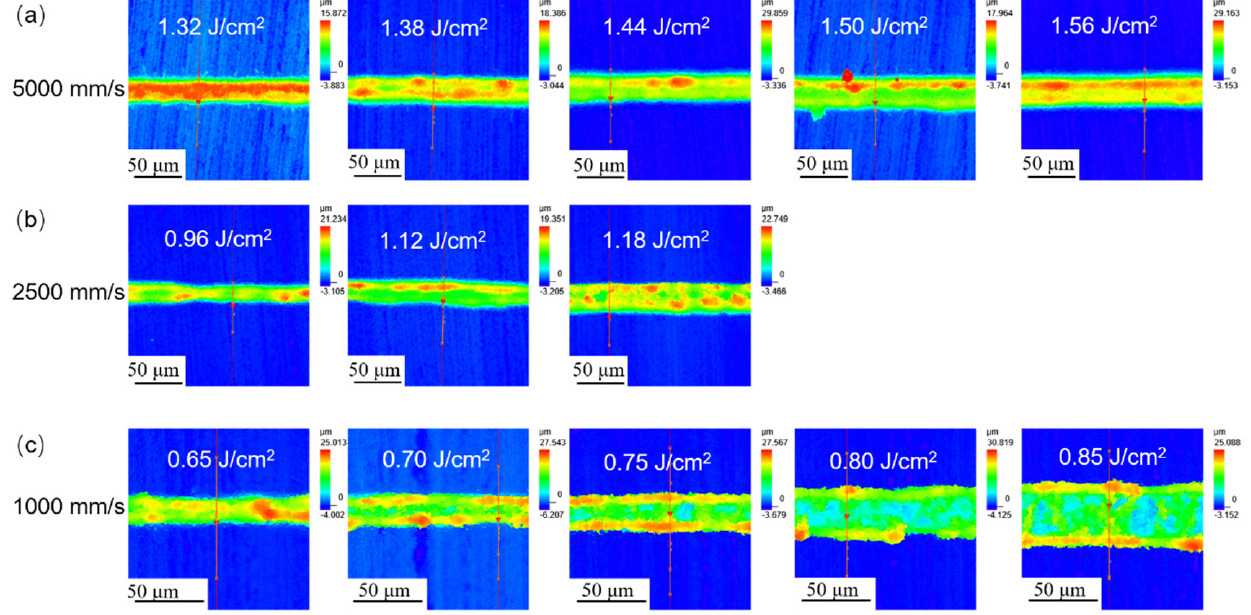
Figure 2. Two-dimensional morphology of the formed lines under different laser fluences and pro- cessing speeds obtained by LSCM. ( a ) 1.32–1.56 J/cm 2 , 5000 mm/s, ( b ) 0.96–1.18 J/cm 2 , 2500 mm/s, ( c ) 0.65–0.85 J/cm 2 , 1000 mm/s.